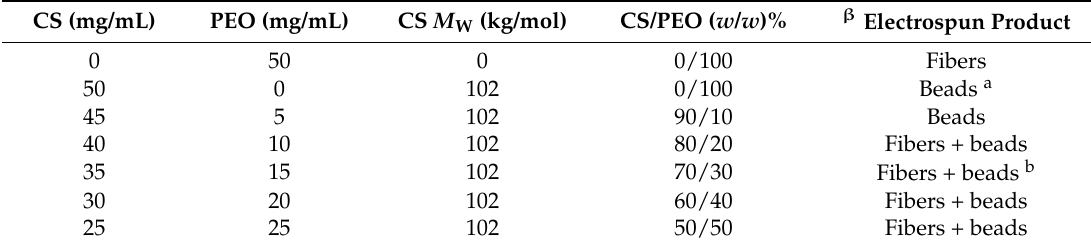
Table 1. Electrospun pure chitosan, PEO (300 kg/mol) and blends of CS/PEO at total polymer